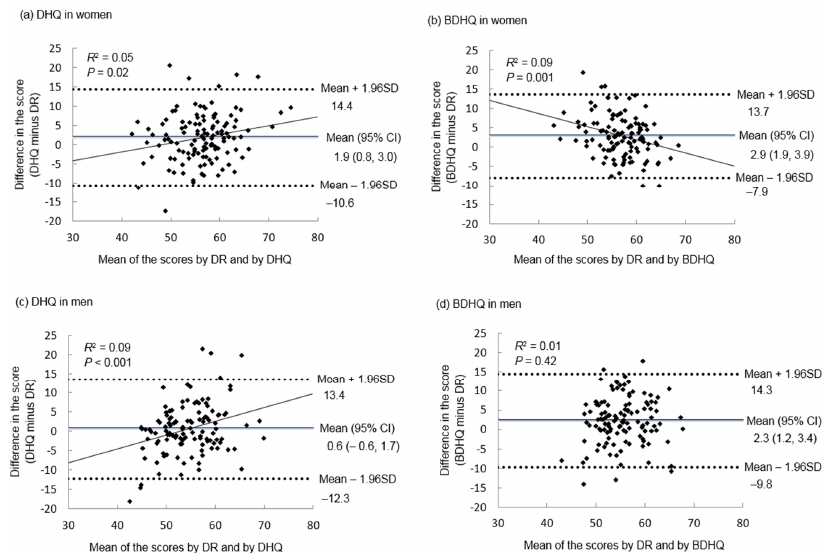
Figure 1. Bland–Altman plots assessing the agreement between the total score of Healthy Eating Index-2015 estimated by a 16-day weighed dietary record (DR) conducted over a year and that estimated by a comprehensive diet history questionnaire (DHQ) or by a brief diet history questionnaire (BDHQ) in Japanese women ( n = 121; ( a ) DHQ and ( b ) BDHQ) and men ( n = 121; ( c ) DHQ and ( d ) BDHQ). In each season, a 4-day weighed DR was conducted: November and December 2002 (autumn), February 2003 (winter), May 2003 (spring) and August and September 2003 (summer). For each individual, the mean value of the 16-day data was used. The DHQ and BDHQ used in this analysis were conducted before the period of the DR (November 2002). A regression line was added when it was statistically significant ( p < 0.05).